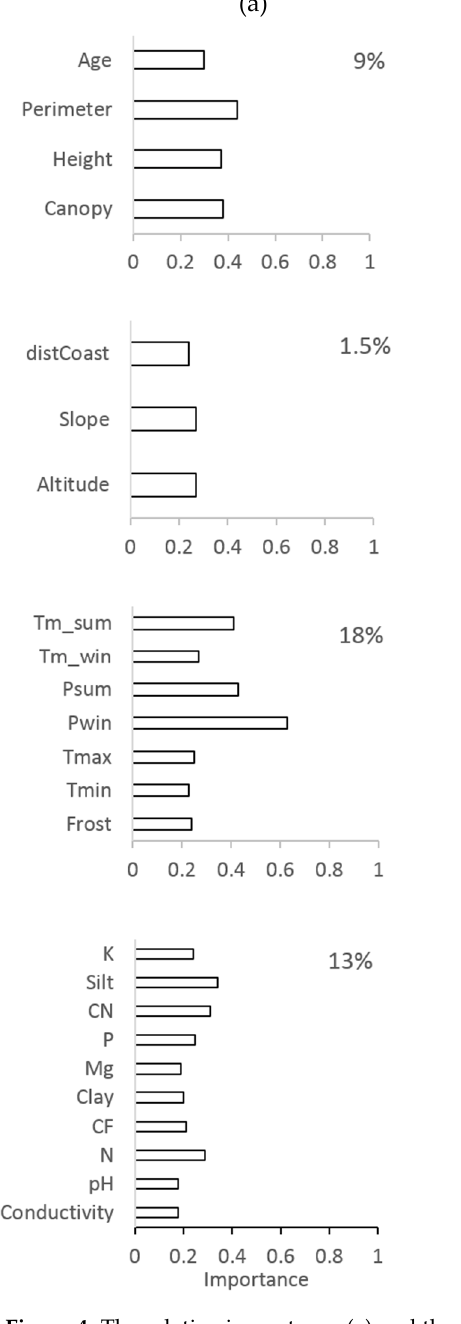
Figure 4. The relative importance ( a ) and the estimated coefficients ( b ) of variables estimated across all fitted GLM models using a multi-model average approach for the Defoliation symptom. We also indicate the percentage of deviance explained by each complete model.